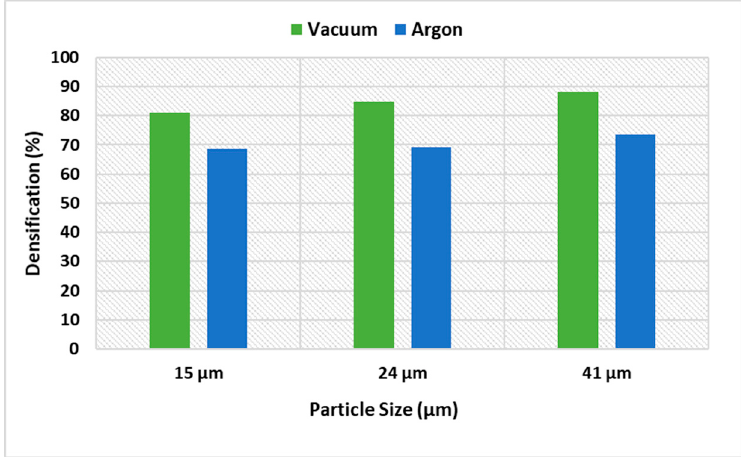
Figure 19. Comparison of vacuum and argon atmosphere influencing the densification with different particle size.